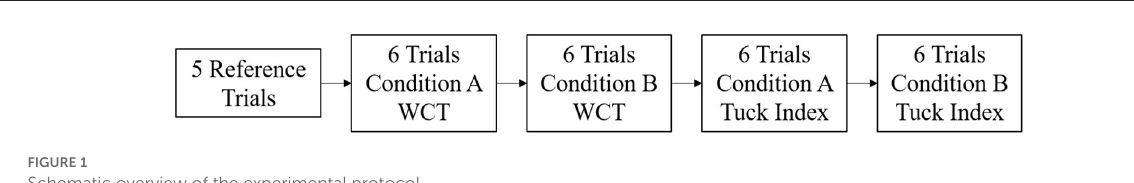
FIGURE1 Schematic overview of the experimental